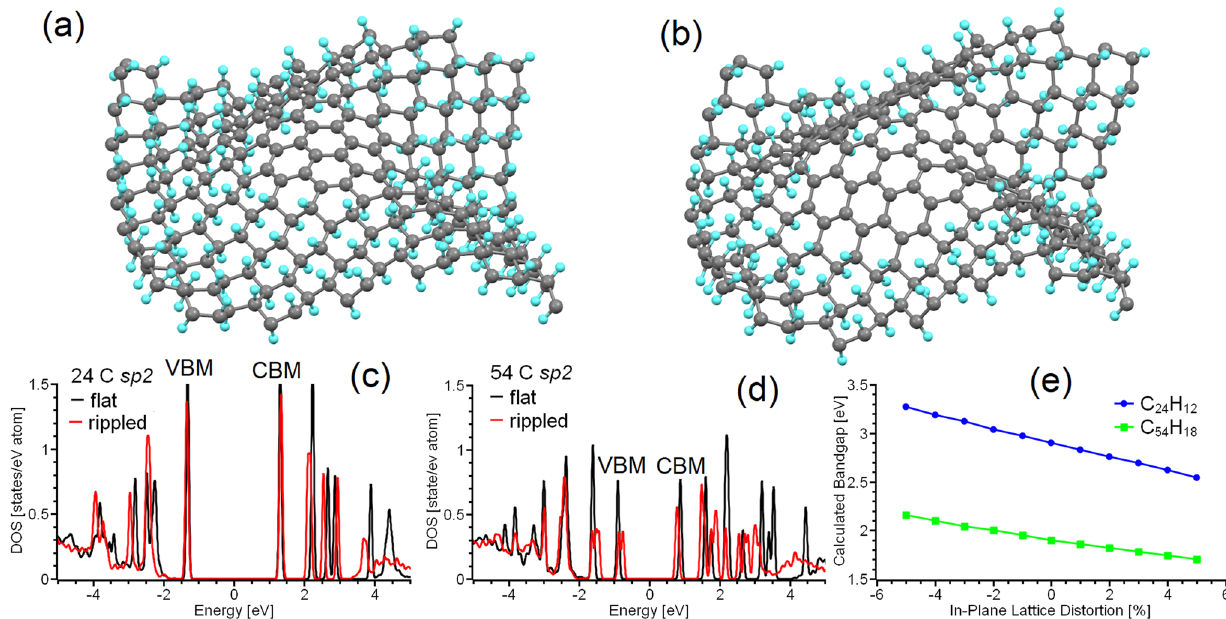
Fig. 3 Optimised atomic structures of corrugated graphene with sp 2 -islands of a 24 and b 54 carbon atoms, and densities of states for sp 2 -islands of c 24 and d 54 in flat and rippled graphane. e The changes of the bandgap of C Fig. 2g) as a function of the change of in-plane lattice parameter. The Fermi energy in ( c ) and ( d ) was set as